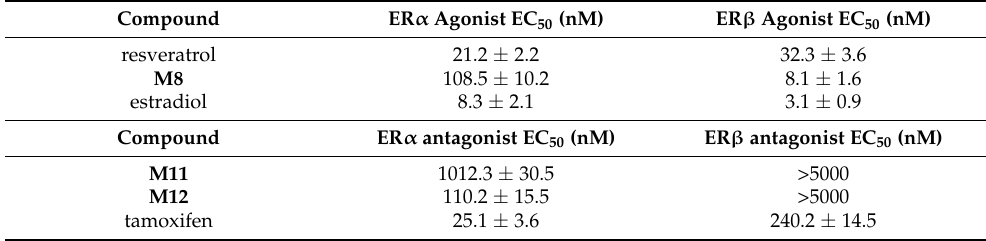
Figure 1. Interaction of resveratrol analogues with human estrogen receptors: ERα (left panel) and ERβ (right panel). In this experiment, only the active compounds are shown. Abbreviations used: Res — resveratrol, M8 —3,4,4′,5 -tetrahydroxystilbene, M11 —3,3′4,5,5′ -pentametoxystilbene, M12 — 3,3′,4,4′,5,5′ -hexahydroxystilbene, T — tamoxifen, E2 — estradiol as a solvent and control DMSO — dimethyl sulfoxide were used. Table 2. Interaction of resveratrol and its analogues with estrogen receptors — EC 50 values.